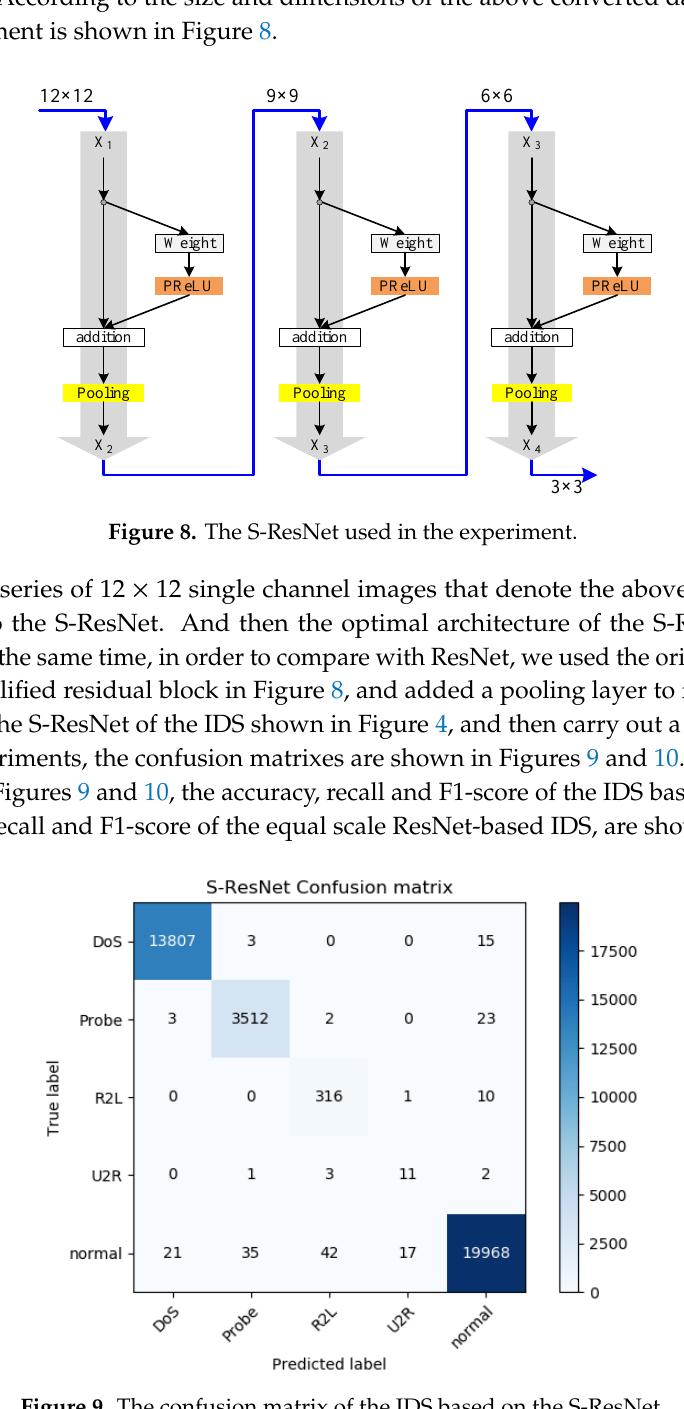
Figure 9. The confusion matrix of the IDS based on the S-ResNet.